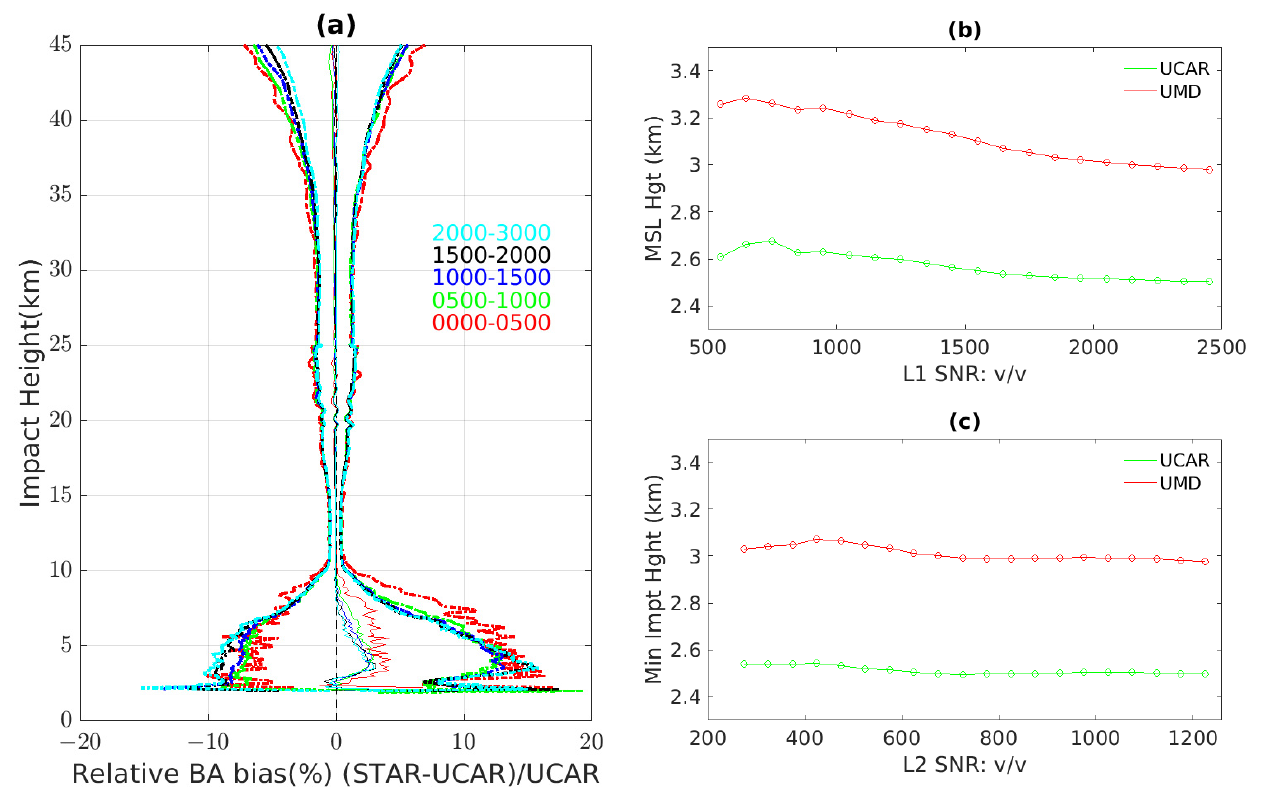
Figure 8. STAR bending angle relative bias compared with UCAR are grouped with SNR values at 80 km impact height (( a ), L2C only). ( b ) and ( c ) show the RO penetration depth of STAR and UCAR (green) related to L1 ( b ) and L2 SNR ( c ).